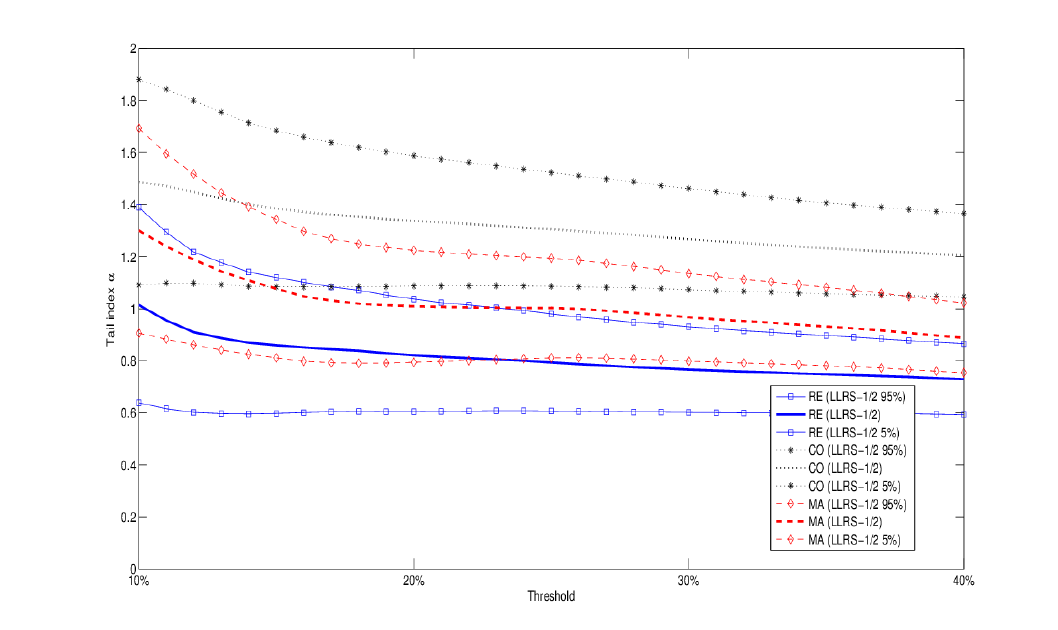
Figure 3. Tail index estimates and 90% confidence bands (LLRS-1/2 regression method) for all Occupancy Level 1 types (CO, MA,